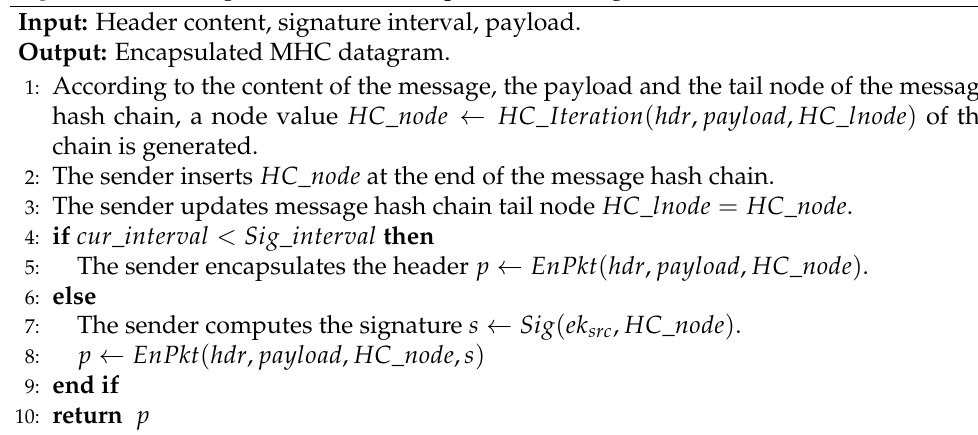
Algorithm 3 Message Hash Chain Encapsulates Messages